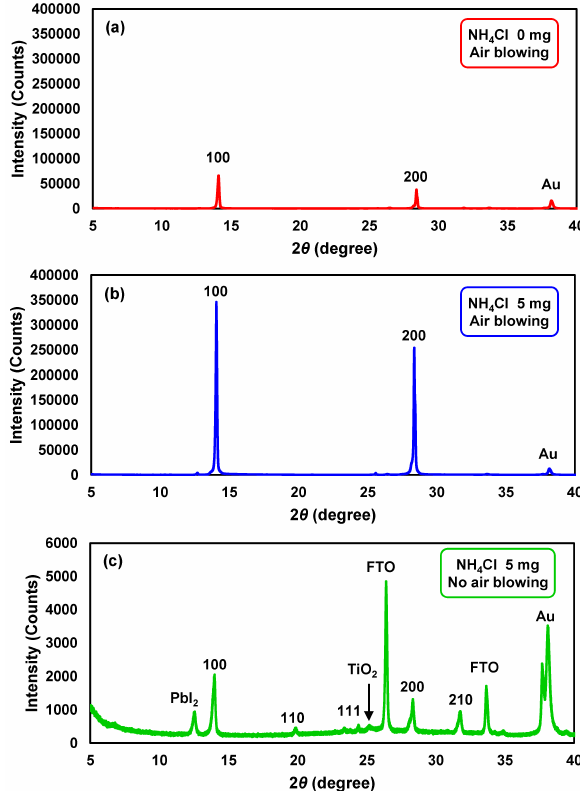
Figure 41: XRD patterns of CH 3 NH 3 PbI 3 (Cl) cells containing (a) 0 mg, (b) 5 mg of NH 4 Cl, and (c) XRD pattern of the CH 3 NH 3 PbI 3 (Cl) cell containing 5 mg of NH 4 Cl without air